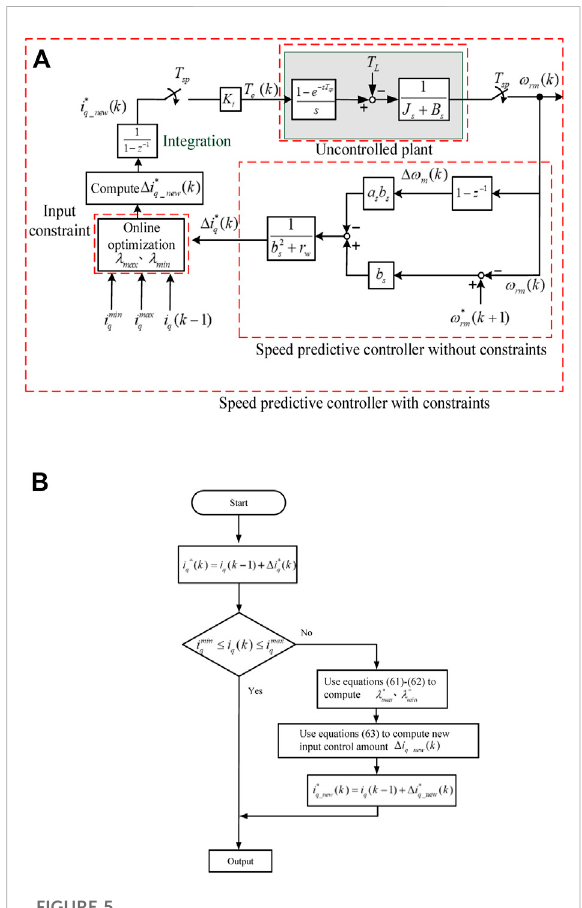
FIGURE 5 Predictive controller with input constraint. (A) Block diagram (B) fl ow